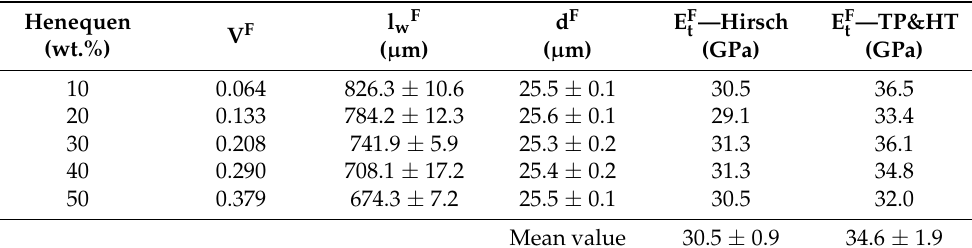
Table 2. Evaluation of the mean fiber length (l wF ), mean fiber diameter (d F ), and intrinsic Young’s modulus estimated using Hirsch and TP & HT models.